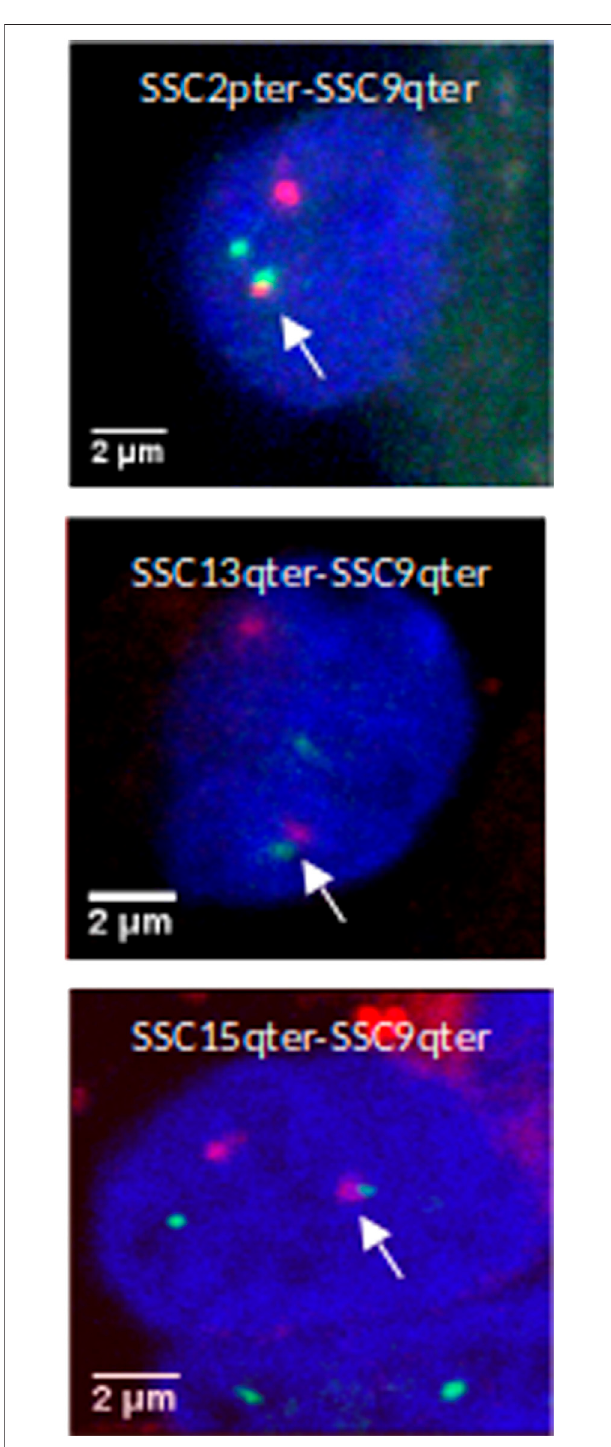
FIGURE 6 | 3D DNA FISH validation of preferential associations of telomeres in muscle cells. 3D images illustrating telomeric associations (SSC2pter – SSC9qter) (SSC13qter – SSC9qter) and (SSC15qter – SSC9qter) at 90 days of gestation. Maximum intensity projections of confocal image stacks are shown. SSC2p, SSC13q and SSC15q telomeres are labelled in green (Alexa 488) and SSC9qter telomere probe in red (Alexa 568). Nucleus DNA was counterstained in blue with